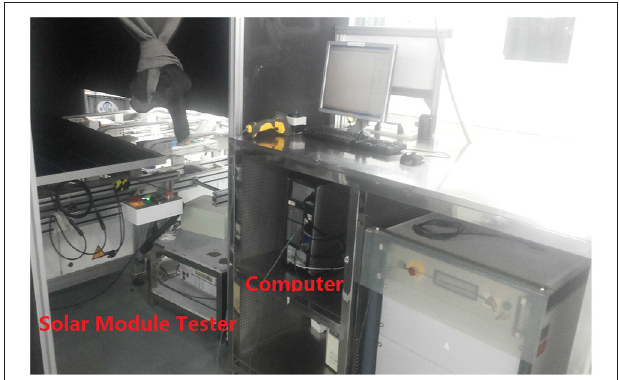
FIGURE 3 | Equipment setup.